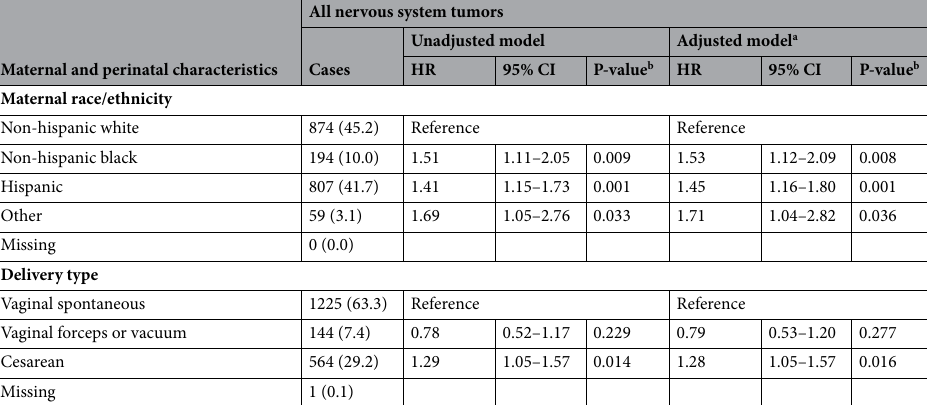
Maternal and perinatal